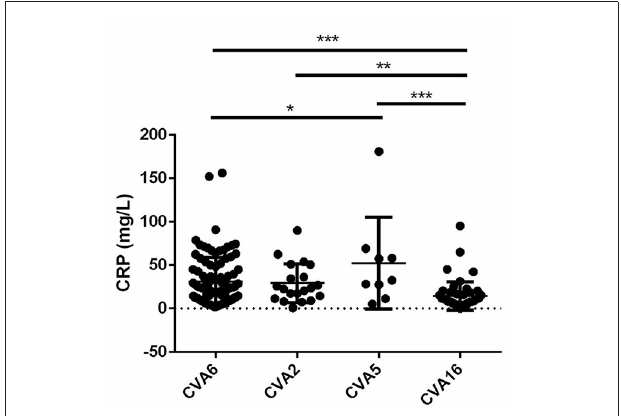
FIGURE 3 | Levels of C-reactive protein (CRP) in cases with CVA6, CVA2, CVA5, and CVA16 (* P < 0.05; ** P < 0.01; *** P <